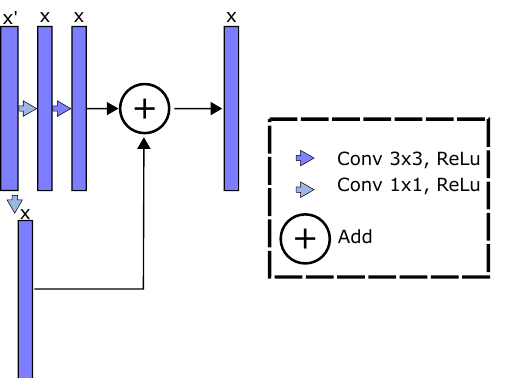
Figure 4. Residual block scheme for ResUnet-based semantic segmentation. The U-net approach is enhanced through residual blocks. The filter size, nonlinear activation, and architecture are